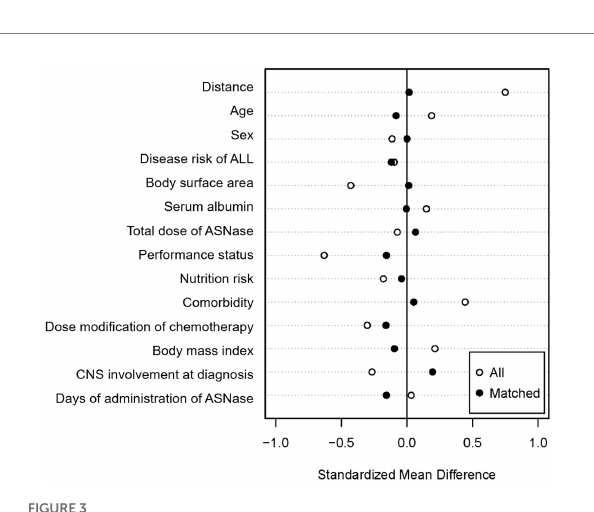
FIGURE 3 Covariate balance after propensity score matching. ALL, acute lymphoblastic leukemia; ASNase, L-asparaginase; CNS, Central nervous system.